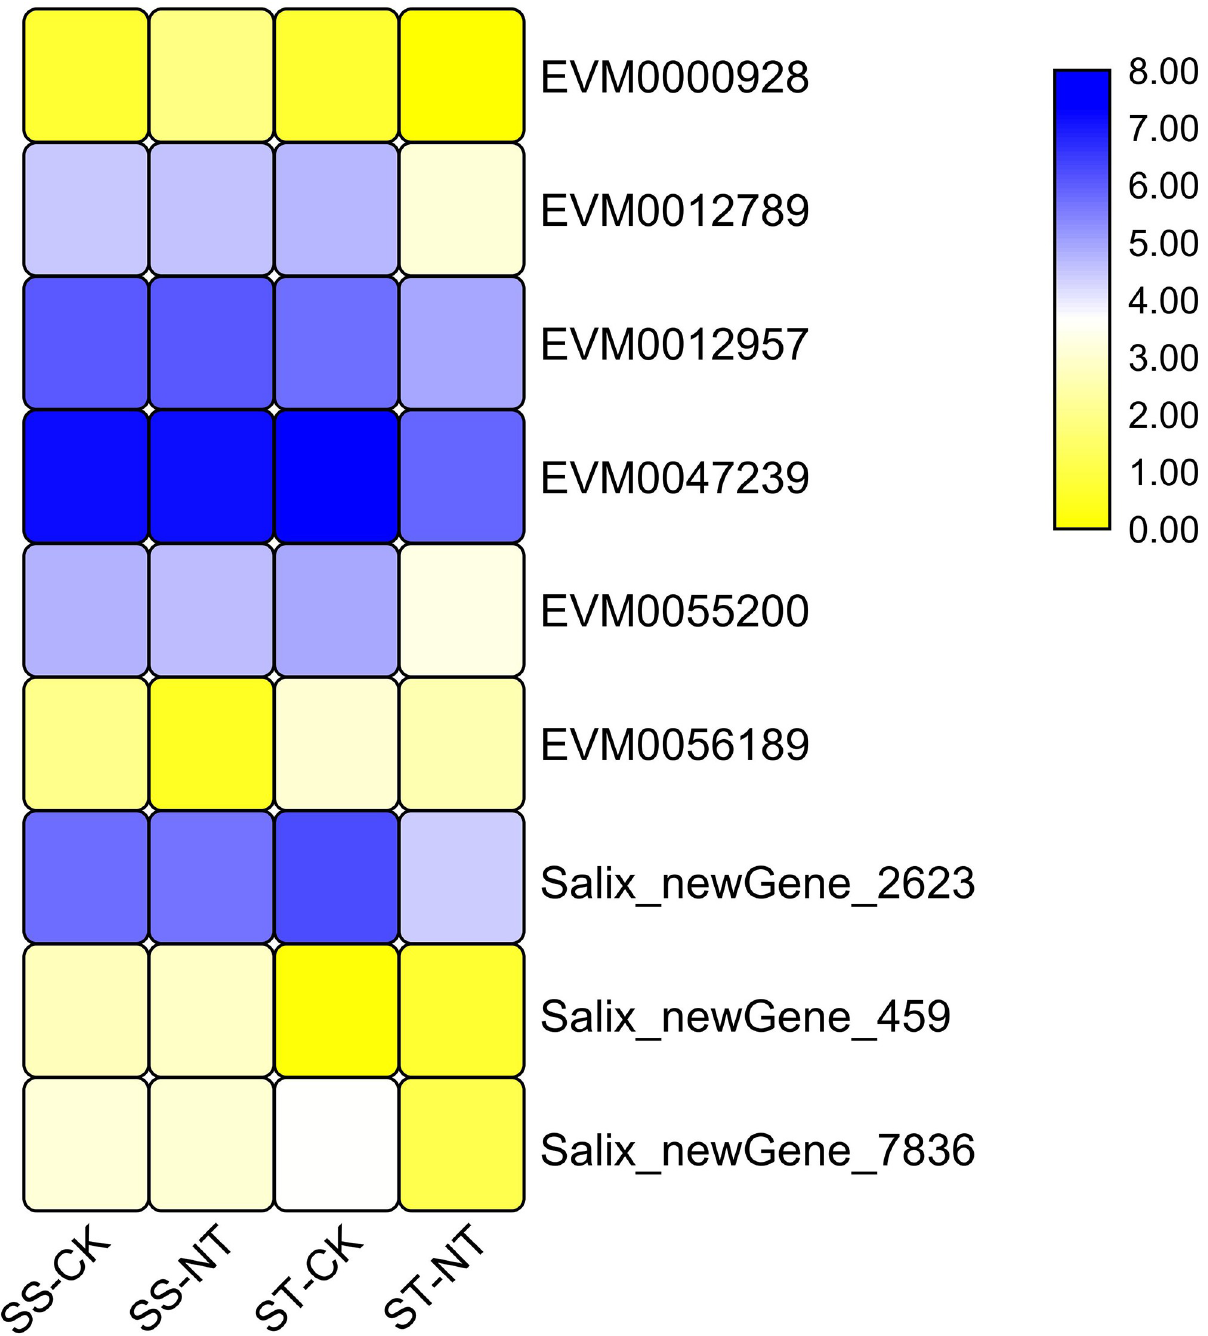
Fig 5. Heatmap presentation of the DEGs from comparison SS-NT vs. ST-NT. The average FPKM values of three repeat samples were counted. The heat map was drawn using Log10-transformed expression values. The color bar indicates the gene expression level. SS-CK and SS-NT indicate the salt- sensitive group samples treated without and with 150 mM NaCl; ST-CK and ST-NT indicate the salt-tolerant group samples treated without and with 150 mM NaCl. DEGs, differentially expressed genes.